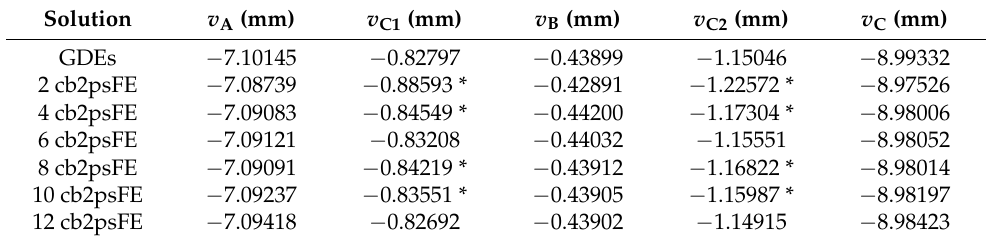
Table 2. Results of transverse displacements for several solutions and